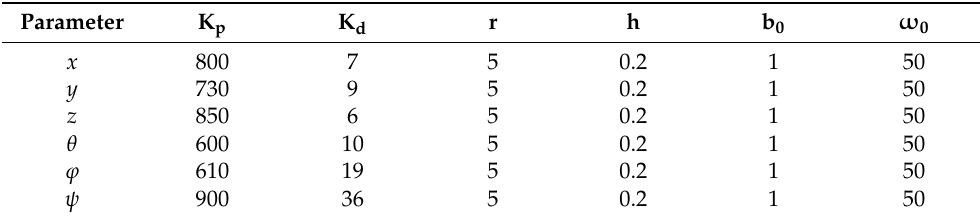
Table 2. Controller